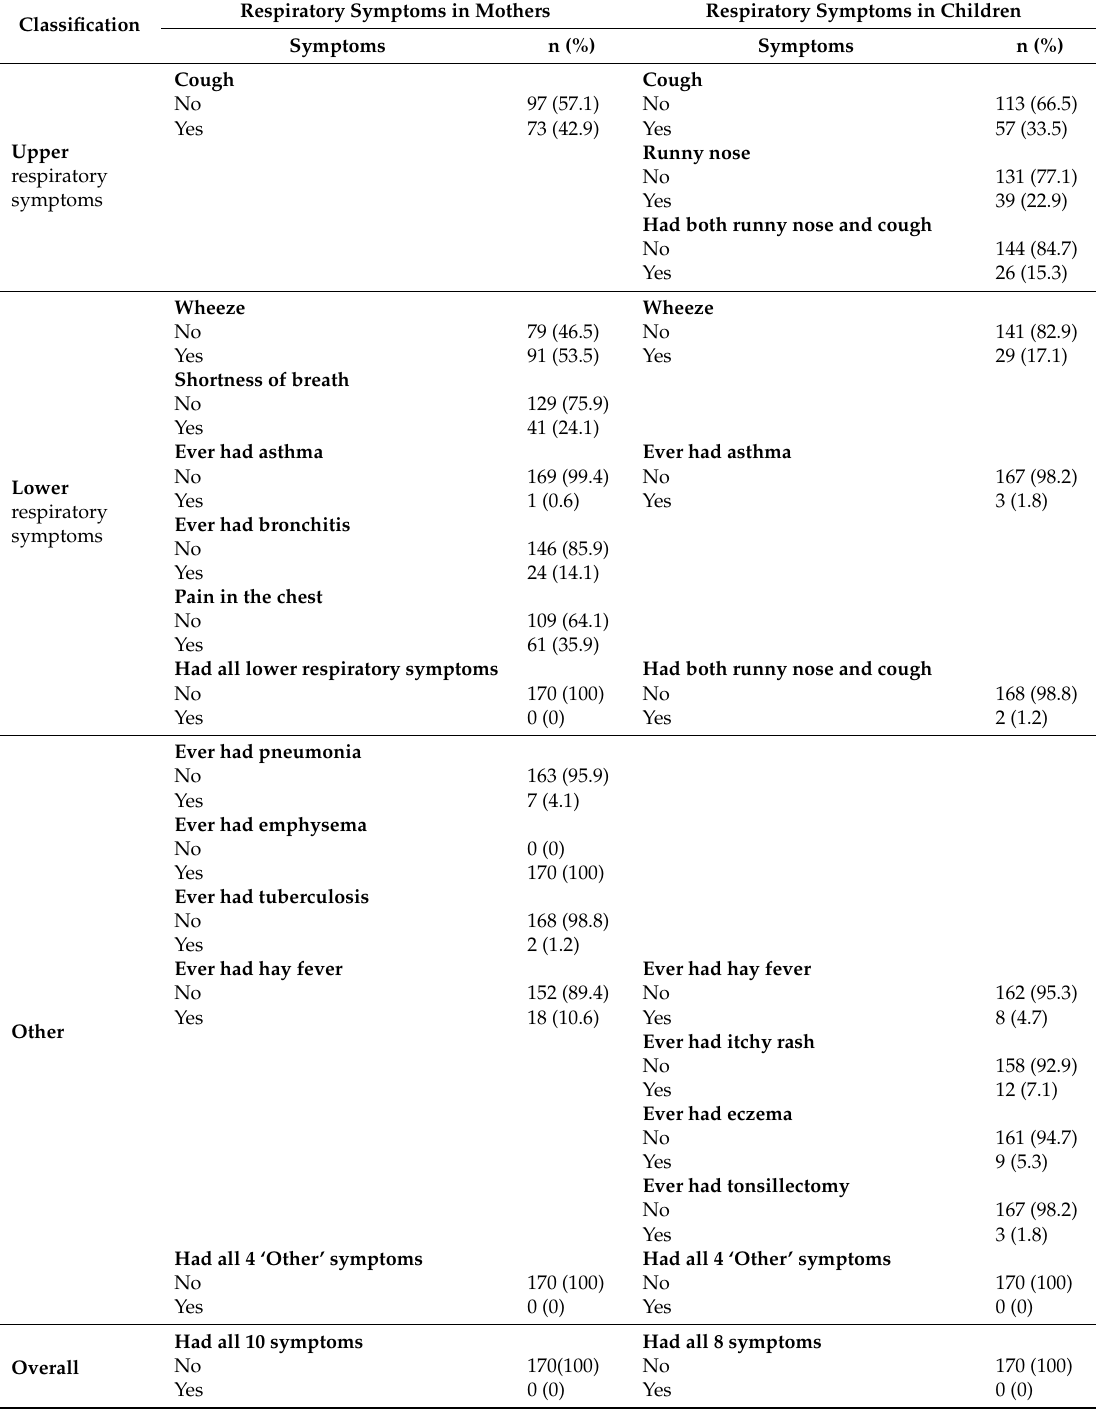
Table 3. Prevalence of respiratory symptoms among mothers and